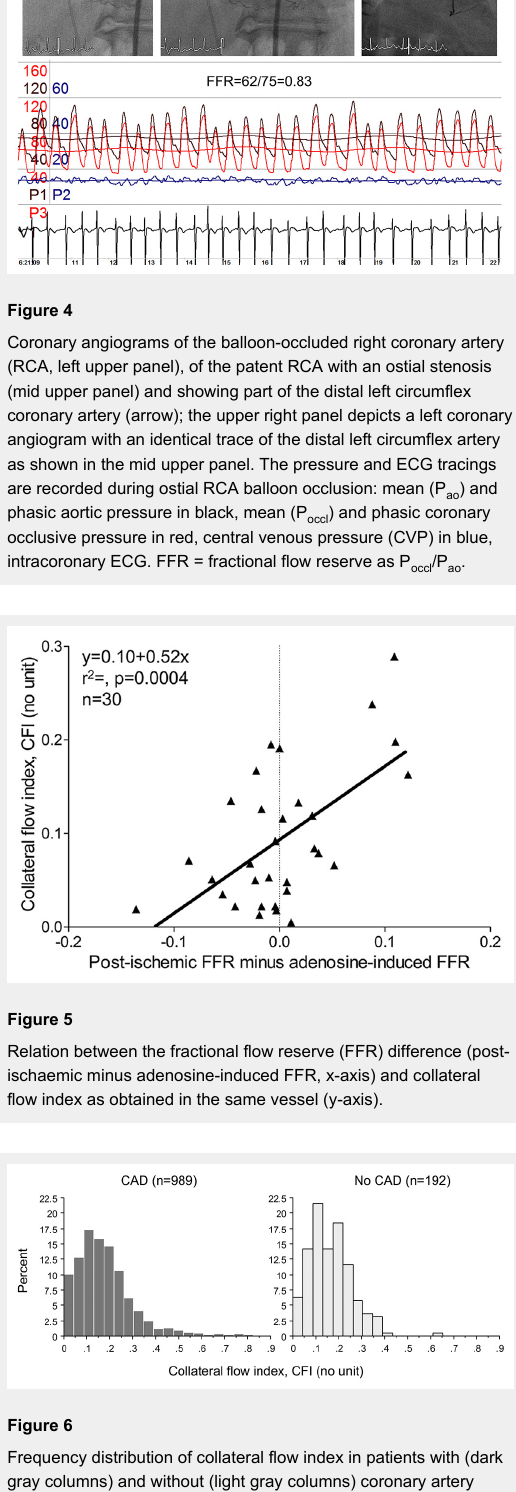
Frequency distribution of collateral flow index in patients with (dark gray columns) and without (light gray columns) coronary artery disease